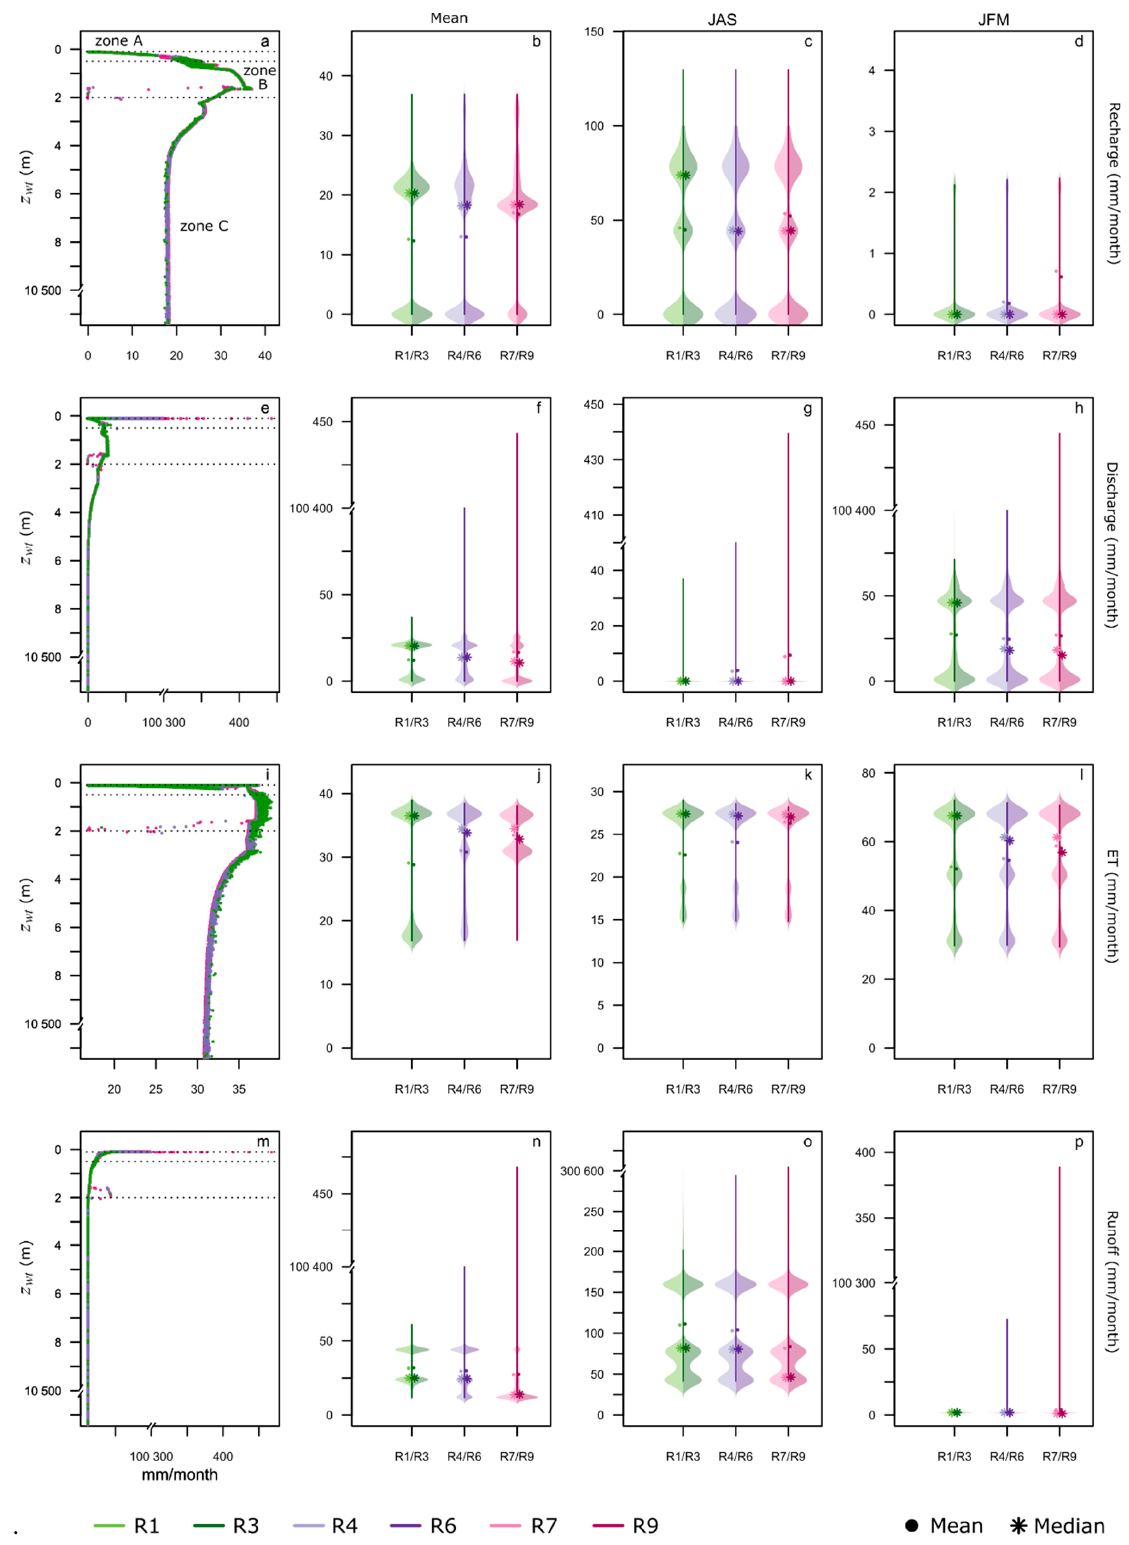
Figure 5. Groundwater recharge and discharge, ET, and runoff against WTD ( a , e , i , m ), and density distributions of cell-mean fluxes for these four variables over annual ( b , f , j , n ), July–September (JAS) ( c , g , k , o ), and January–March (JFM) ( d , h , l , p ) periods for different aquifer parameterisations. The dotted line in ( a , e , i , m ) represents the depth of the soil layers. Note the broken axis on 10 of the plots.